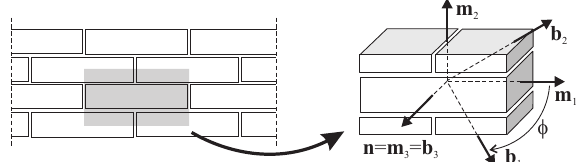
Figure 1. Axes of orthotropy { m i } and a Cartesian system { b i }